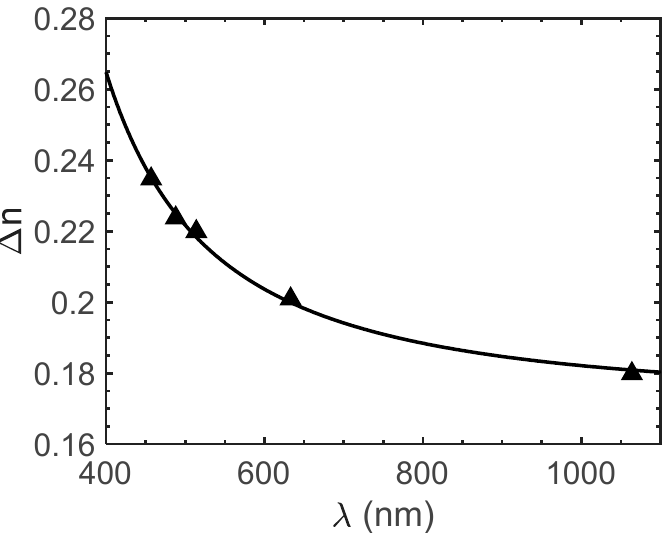
Figure 2. Wavelength-dependent birefringence of A4907 at 40 °C and 1 kHz. Triangles are measured data and solid line is fitting curve with Equation (2).